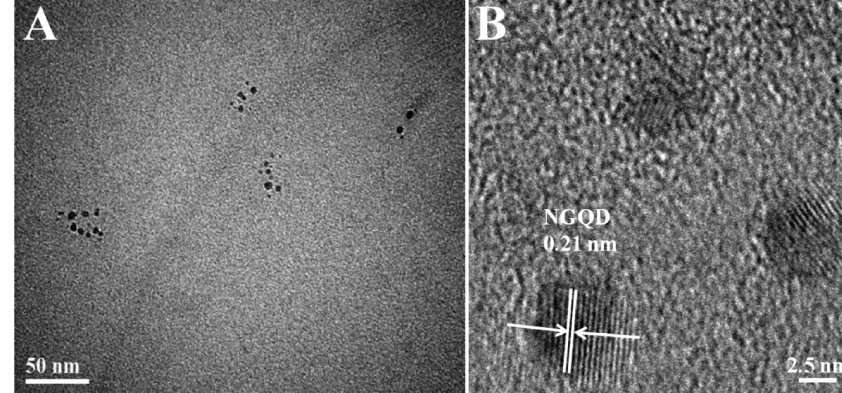
Figure 2: The lattice fringe in Figure 2B is about 0.21 nm. TEM (A) and HRTEM (B) images of NGQDs prepared in 200 ° C.